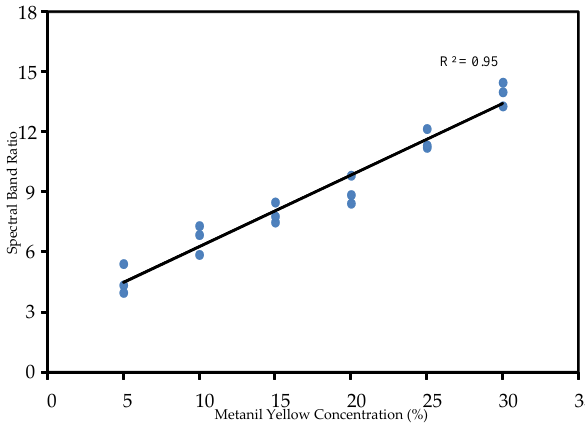
Figure 9. Linear relation between FT-IR spectral peak intensity and sample